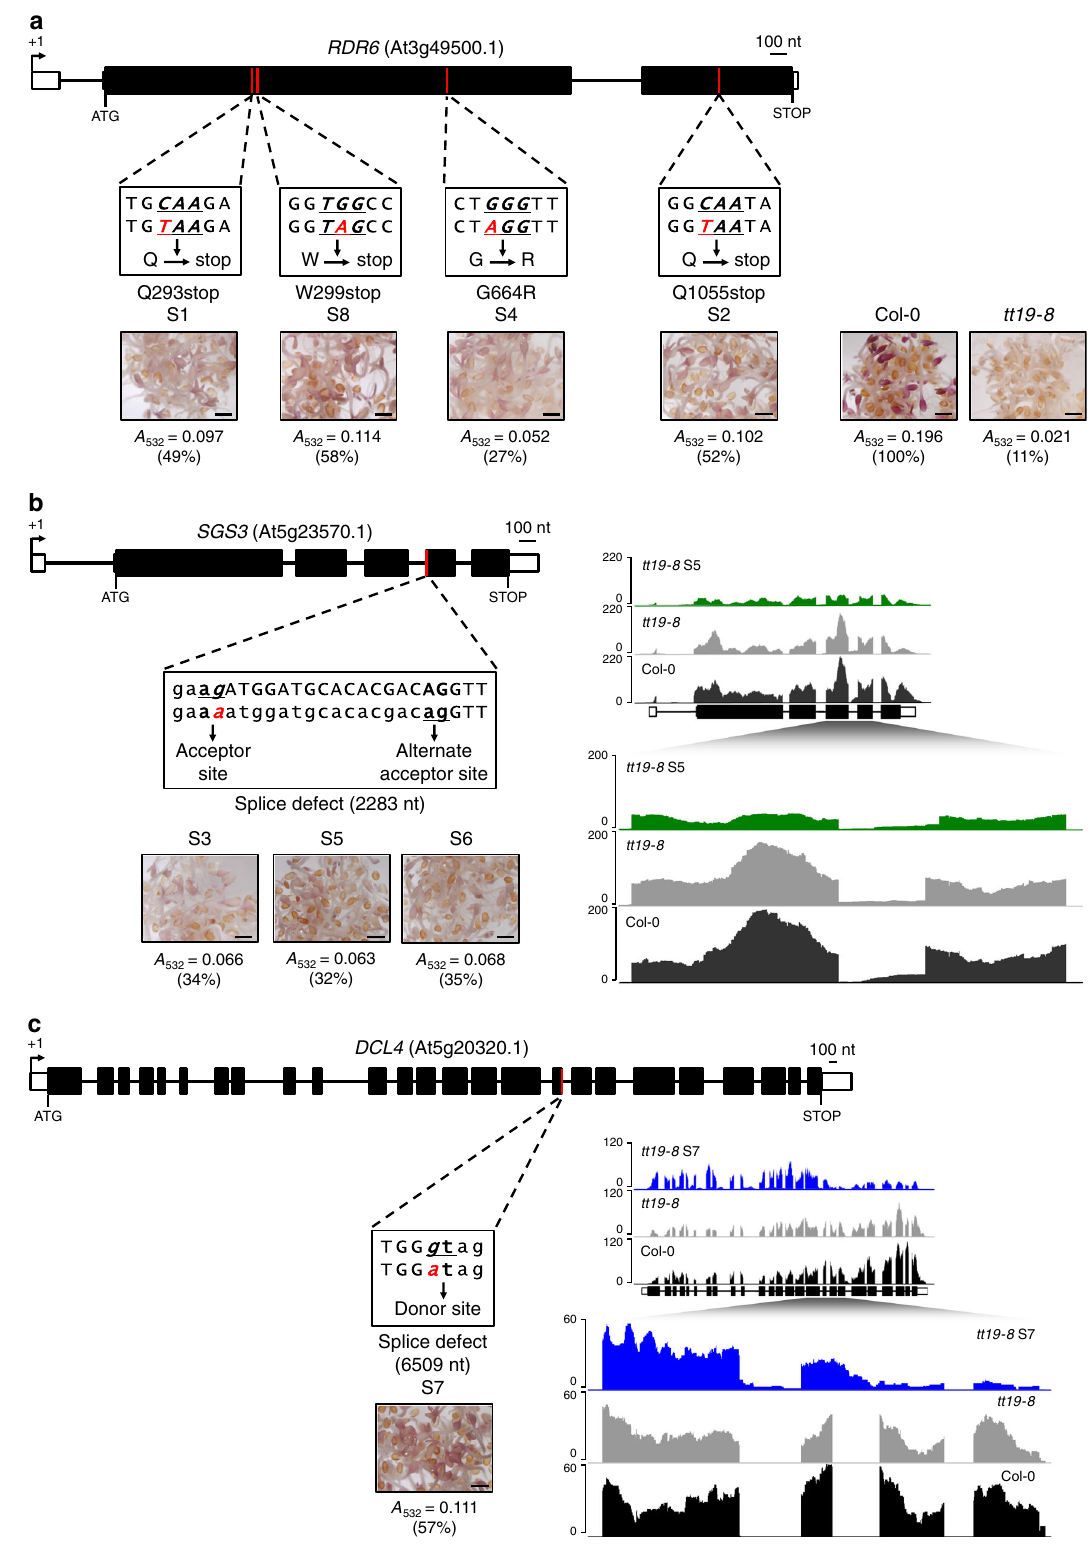
developmental stages grown on soil (Supplementary Fig. 4). In contrast to the restoration of anthocyanin accumulation in vegetative organs, none of the eight tt19 suppressors was able to reinstate the seed coat PA pigmentation characteristic of wild-type and signi fi cantly reduced in tt19-8 plants (Supple- mentary Fig.